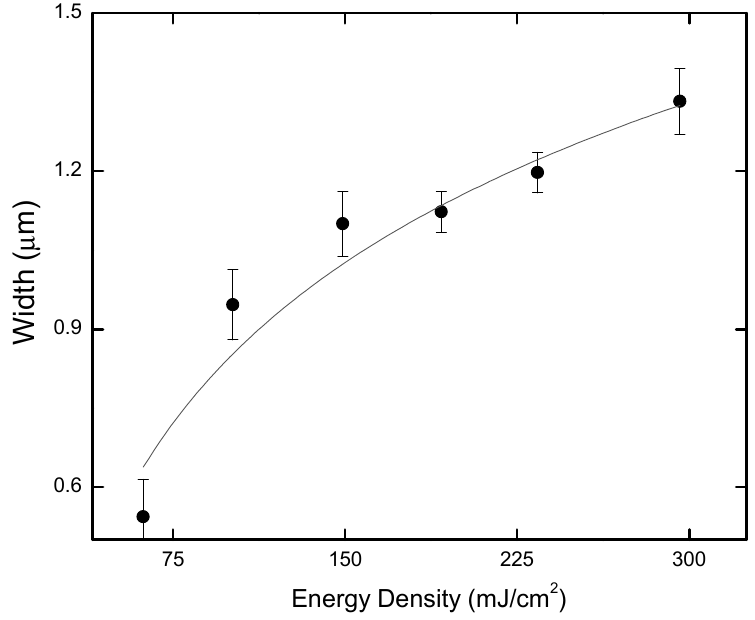
Figure 2. Width of micromachined lines as a function of energy density, for a scan speed of 50 μ m/s. The solid line is only drawn to guide the eye.